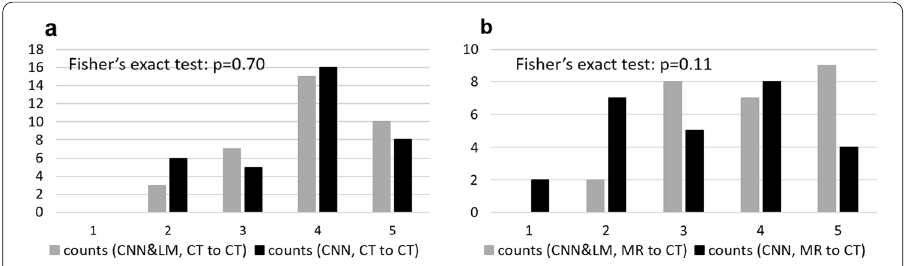
Fig. 8 Likert scores for the registered landmarks of floating CT ( a ) and MR ( b ) images using the CNN&LM-guided and CNN-guided registrations